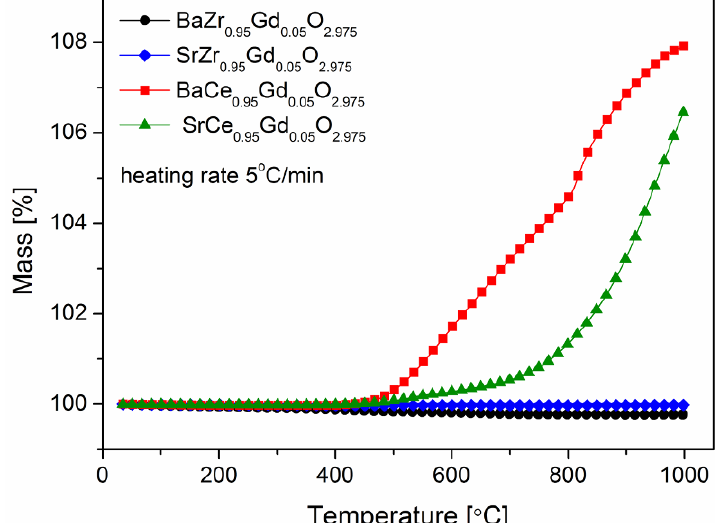
Figure 9. TG curves of proton conductors in CO